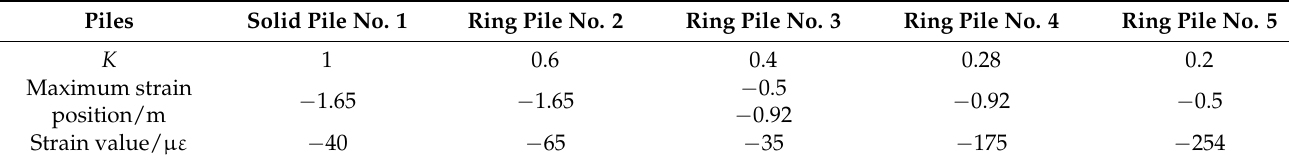
Table 5. The position and size of the peak strain of the pile body.